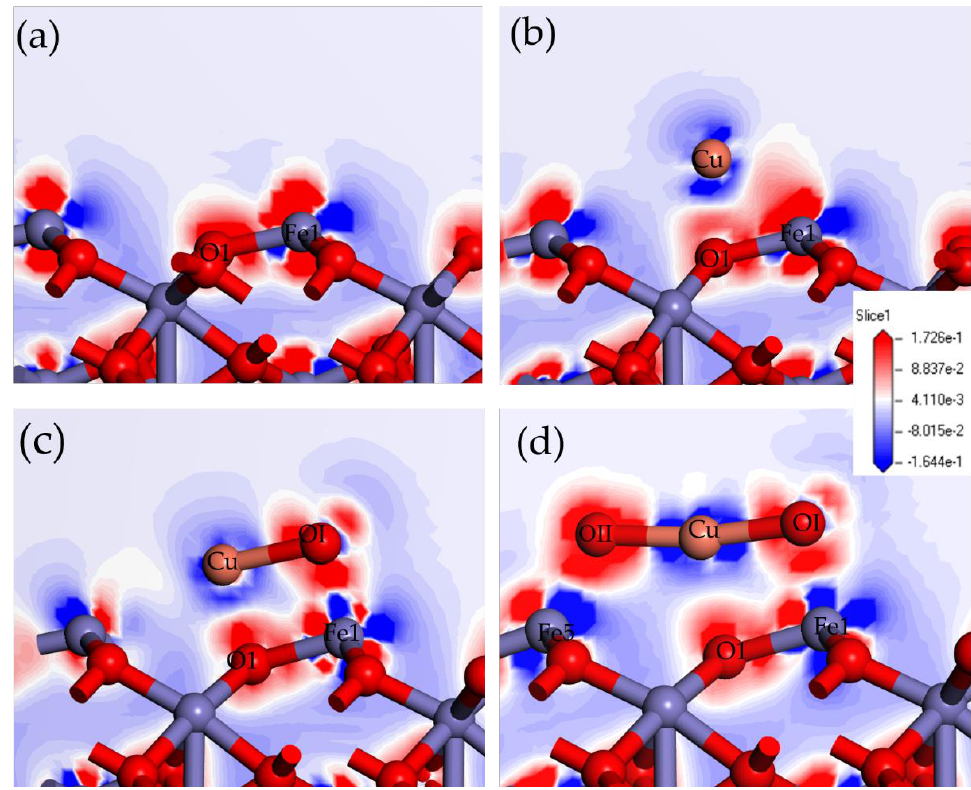
Figure 6. Electron density of different adsorbents adsorbed on the surface of specularite: ( a ) Original, ( b ) Cu 2+ , ( c ) Cu(OH) + , ( d ) Cu(OH) 2 .